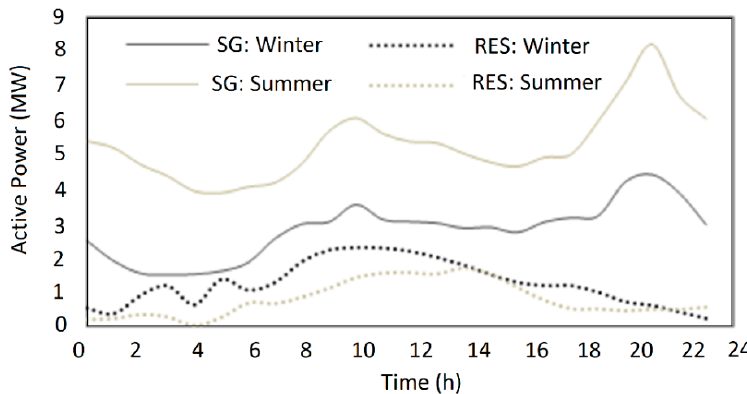
Figure 3. Daily generating profile of SGs and RESs in Pantelleria.